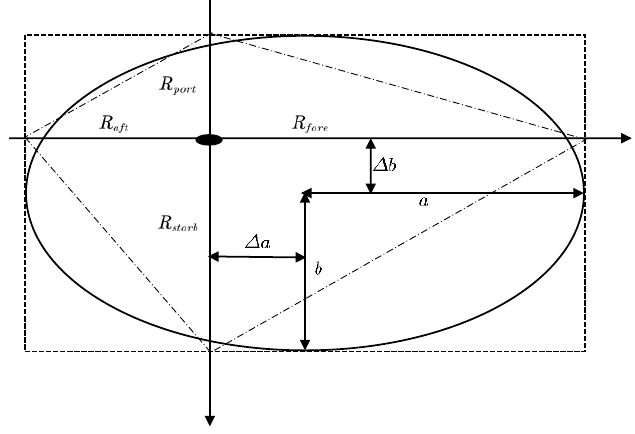
Figure 5. Elliptic dynamic ship domain model.